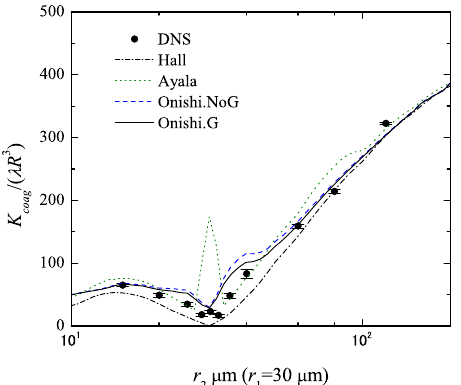
Figure 4. Non-dimensionalized coagulation kernels for r 1 = 30µm in the turbulent flow with Re λ = 127 and (cid:15) = 400cm 2 s − 3 . The er- ror bars show ± 1 standard deviation obtained from more than three runs, with each run lasting for a time T 0 = L 0 /U 0